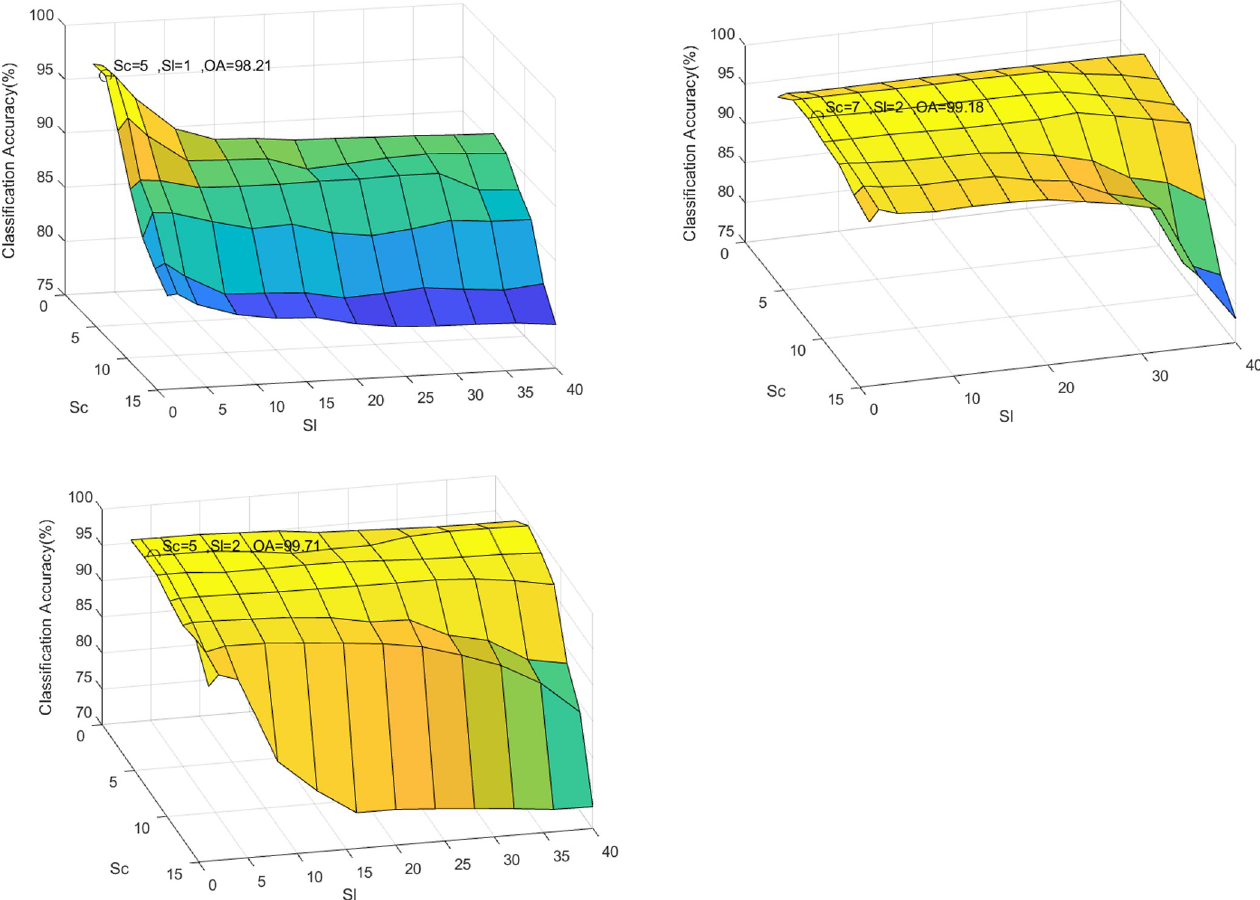
Fig 3. Effect of Sl and Sc. (a) Indian Pines, (b) Pavia University, and (c) Salinas Scene.